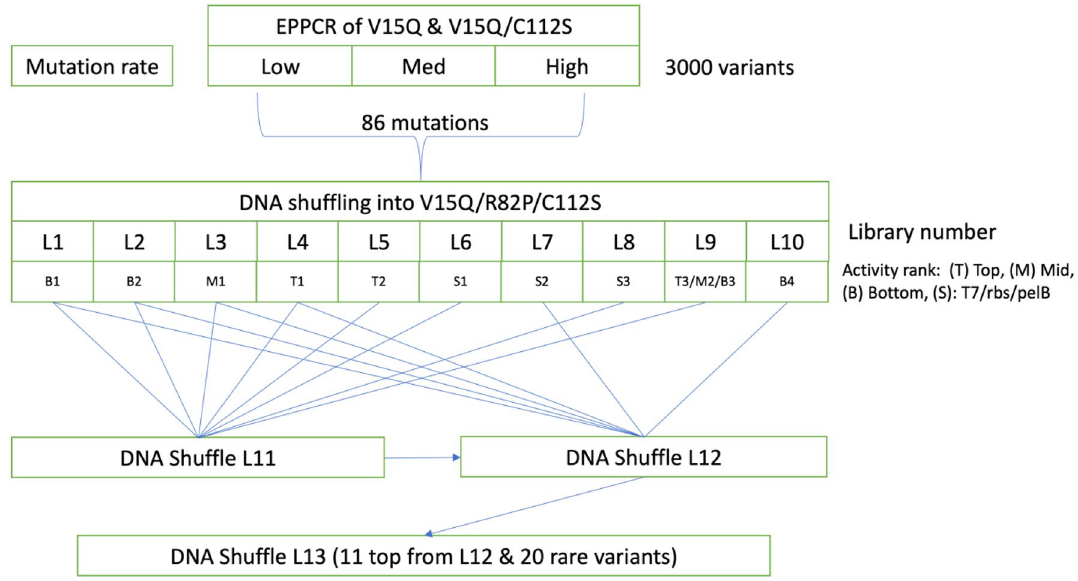
Figure 2. Schematic of overall library generation and iteration strategy. Error-prone PCR (EPPCR) generated the initial 3000 variants from libraries with three different mutation rates. DNA shuffling of the 86